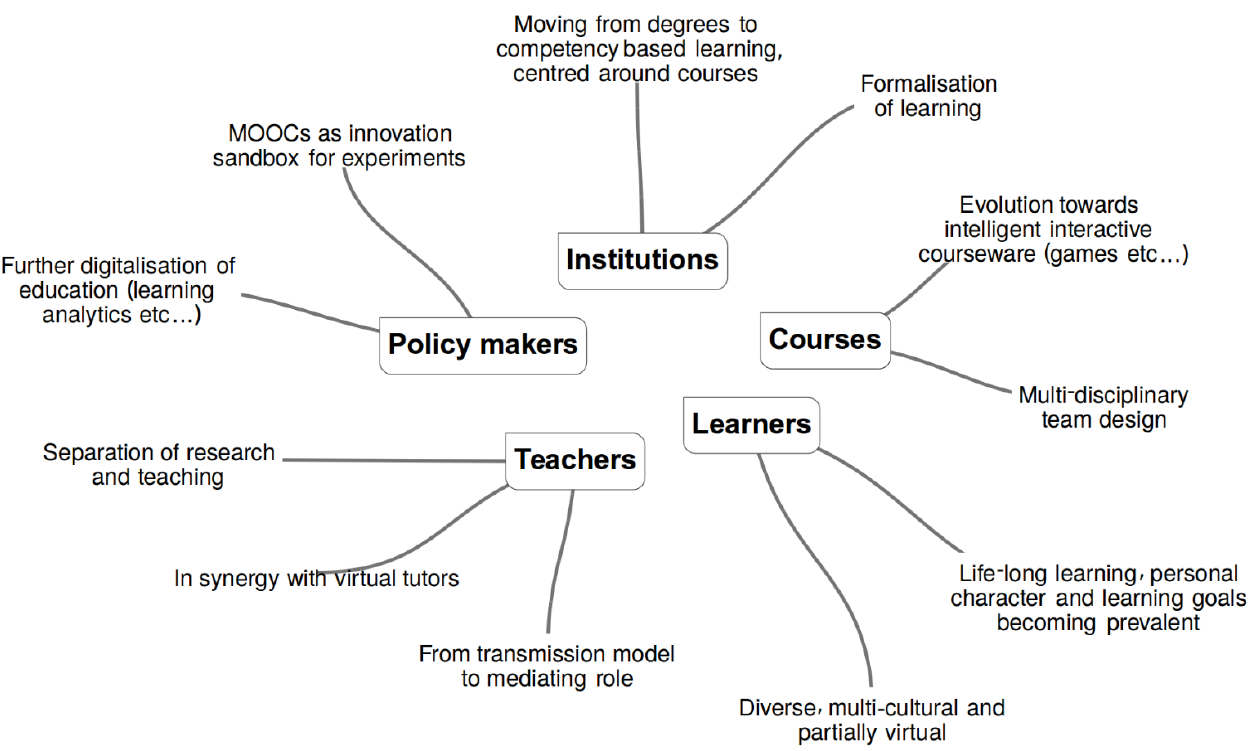
Figure 3 . The global landscape of education might significantly change due to digitalization of teaching of which MOOCs are a manifestation. The most remarkable (potential) shifts are summarized for each actor in the ecosys